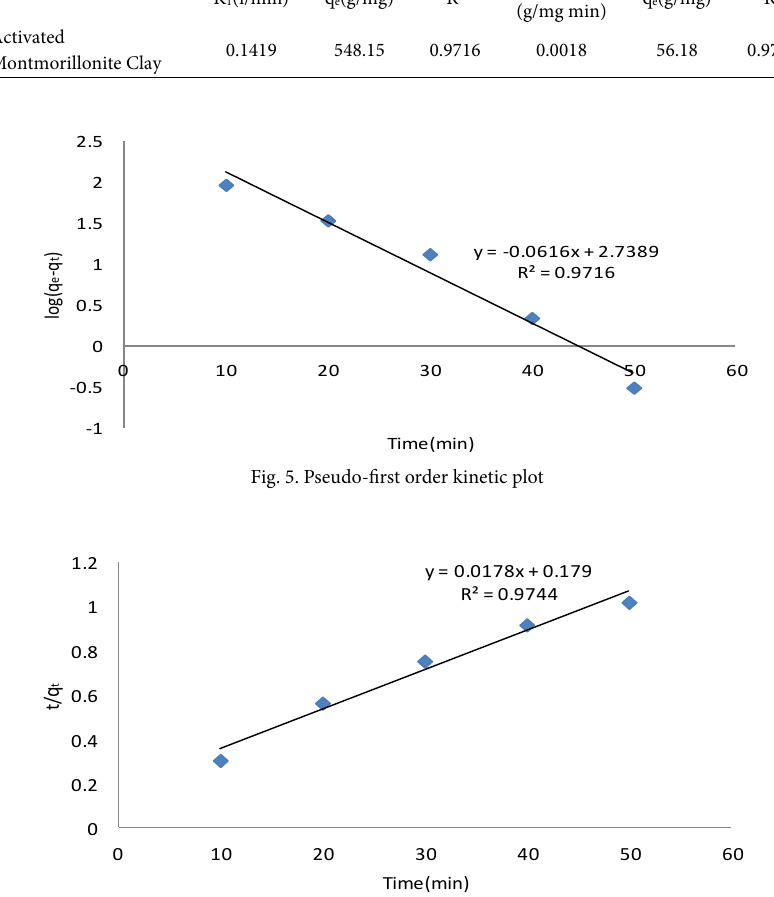
Fig. 6. Pseudo-second order kinetic